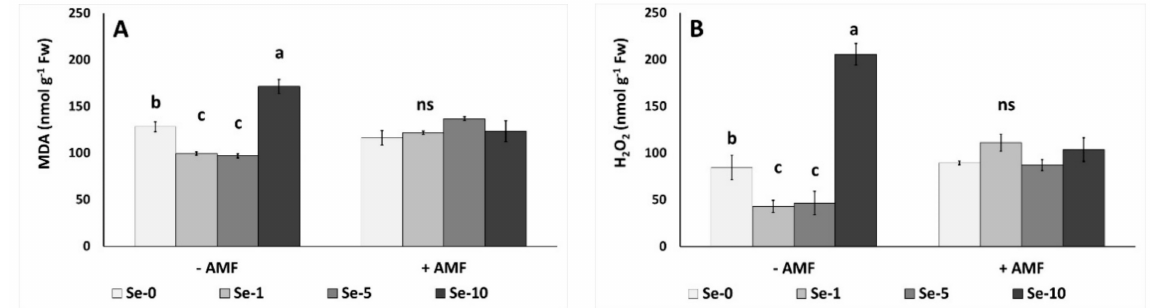
Figure 3. Effects of arbuscular mycorrhizal fungi (AMF) inoculation and selenium (Se) levels (0, 1, 5 and 10 mg L − 1 ) in the nutrient solution on fruit lipid peroxidation and hydrogen peroxide in hydroponically grown strawberries in cocosoil. ( A ) Lipid peroxidation-MDA and ( B ) hydrogen peroxide-H 2 O 2 . Significant differences ( p < 0.05) among selenium treatments are indicated by different letters. Error bars show SE (n =